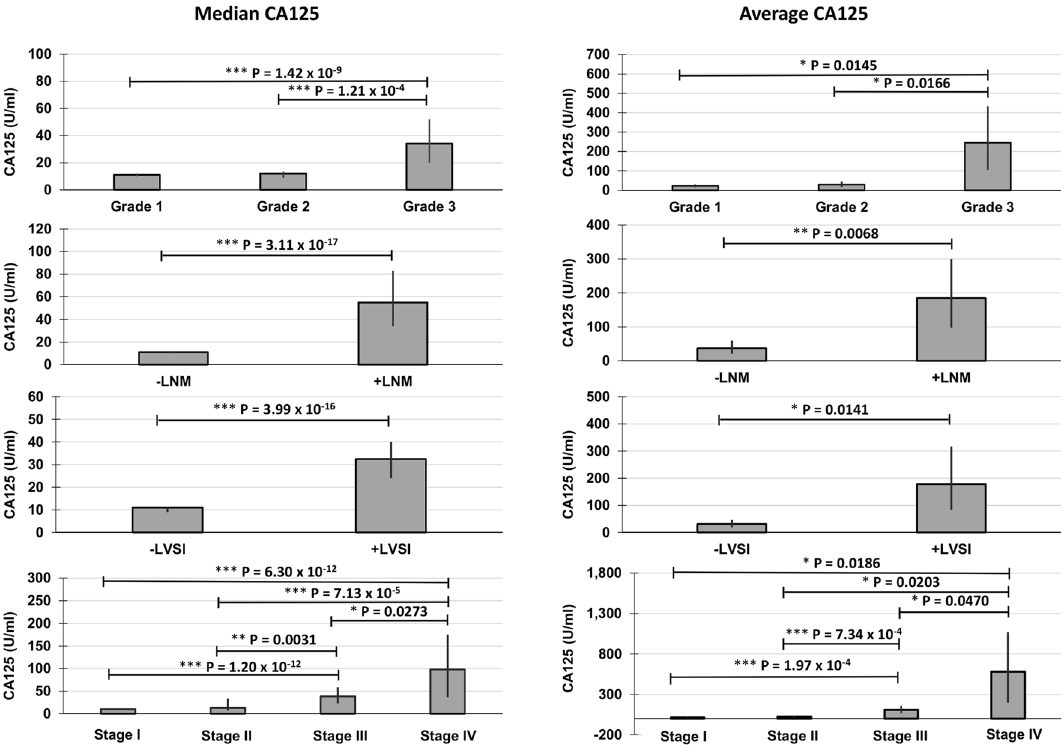
Figure 2. Median CA125 (U/ml) (left) and average CA125 (U/ml) (right) for all patient classifications. LVSI = lymphovascular space invasion; LNM = lymph node metastasis. Bars represent 95% CI. For medians, a Wilcoxon rank-sum test was used for statistical significance. For averages, a student’s T-test was used. * p ≤ 0.05; ** p ≤ 0.01; *** p ≤ 0.001.